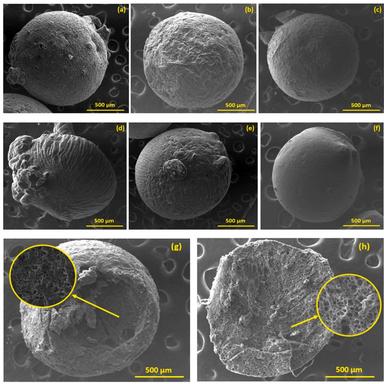
SEM images of EPCMs: (a) DO@Alginate, (b) DO@CMC, (c) DO@Chitosan, (d) DO@Alginate@Al2O3, (e) DO@CMCAl2O3, (f) DO@Chitosan@Al2O3 and cross-sectional images of optimal EPCMs: (g) DO@CMC@Al2O3 and (h) DO@Chitosan@Al2O3.